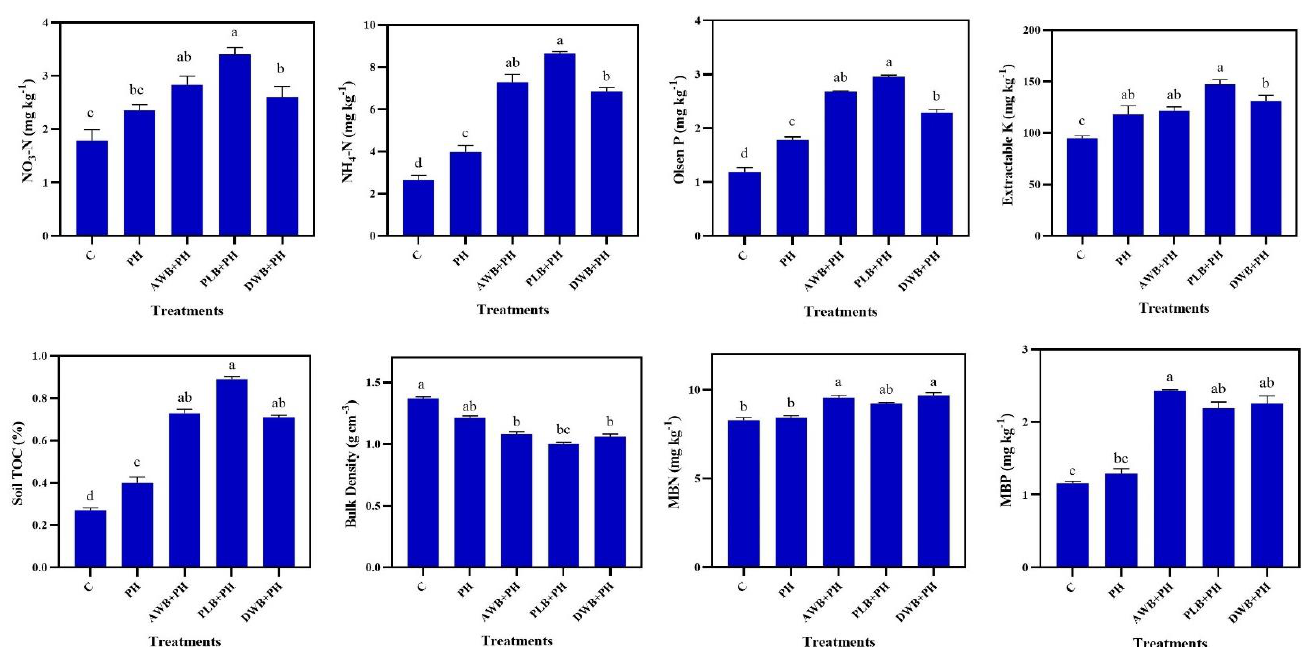
Figure 2. Effect of each treatment on soil nutrient content under field conditions. Small letters on bars indicate significant differences among treatments at 5% probability levels, where significance was tested by using the multiple comparison LSD test. Error bars show the standard error of the mean (n = 3). Treatment abbreviations can be found in Table 1.